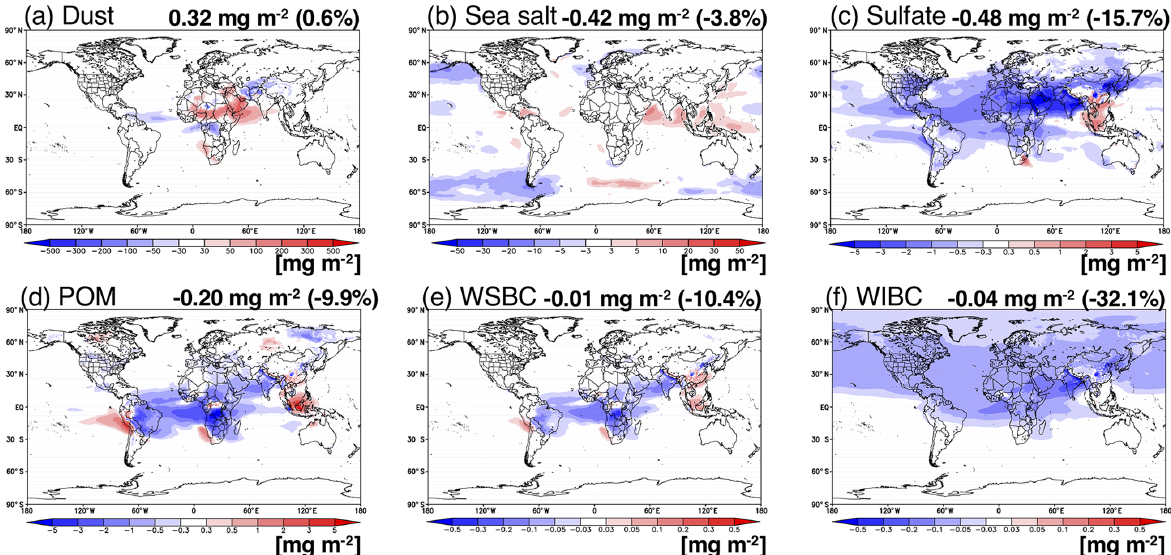
Figure 7. Global distribution of the differences in the mass loadings of (a) dust, (b) sea salt, (c) sulfate, (d) POM, (e) WSBC and (f) WIBC between the HRM and LRM (LRM minus HRM) for the annual averages with a grid of 0 . 5 ◦ × 0 . 5 ◦ . The numbers shown in the upper-right corner in each panel represent the annual and global averages of the difference in units of mgm − 2 , and the numbers in brackets represent the annual and global averages of the relative difference in units of